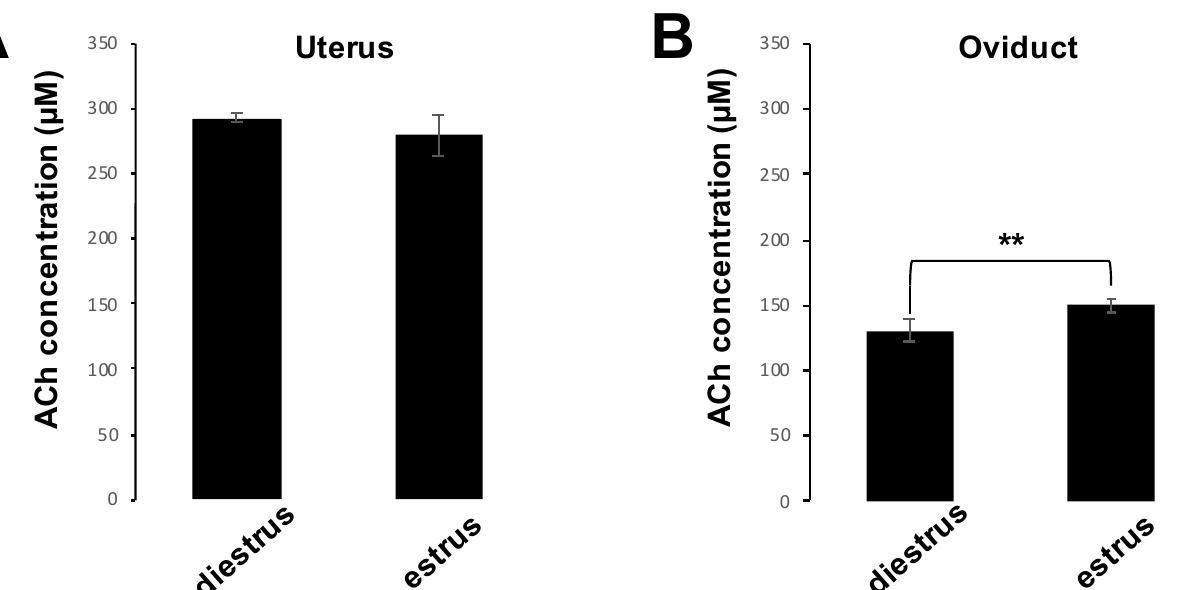
Figure 1. ACh concentrations in mouse uterus and oviduct during diestrus and estrus phase. ( A , B ) Acetylcholine (Ach) concentration ( µ M) in uterus ( A ), and oviduct ( B ). Data shown as mean ± SD ( n = 5; ** p < 0.01).